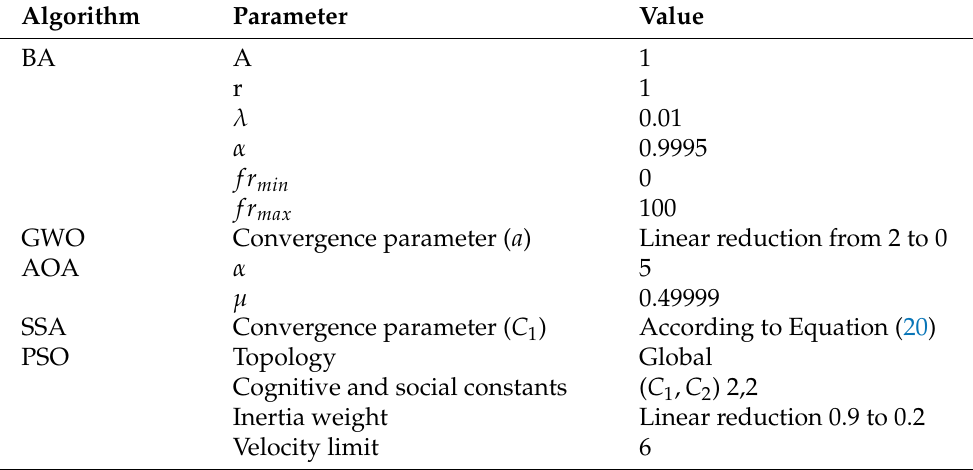
Table 1. Parameter values for the comparative algorithms.